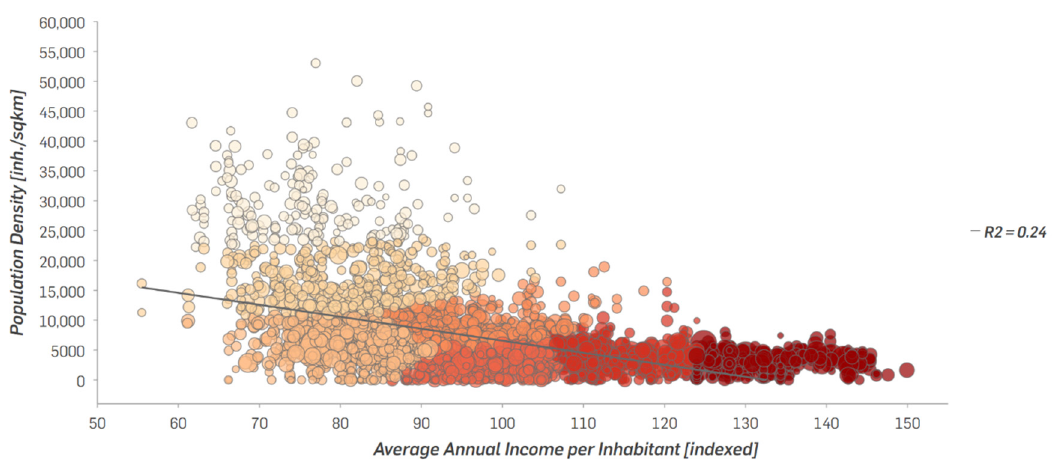
Figure 9. Regression analysis for average annual income per inhabitant and population density in city block-polygons, dot size in scatterplot proportional to relative polygon area (Source: authors).